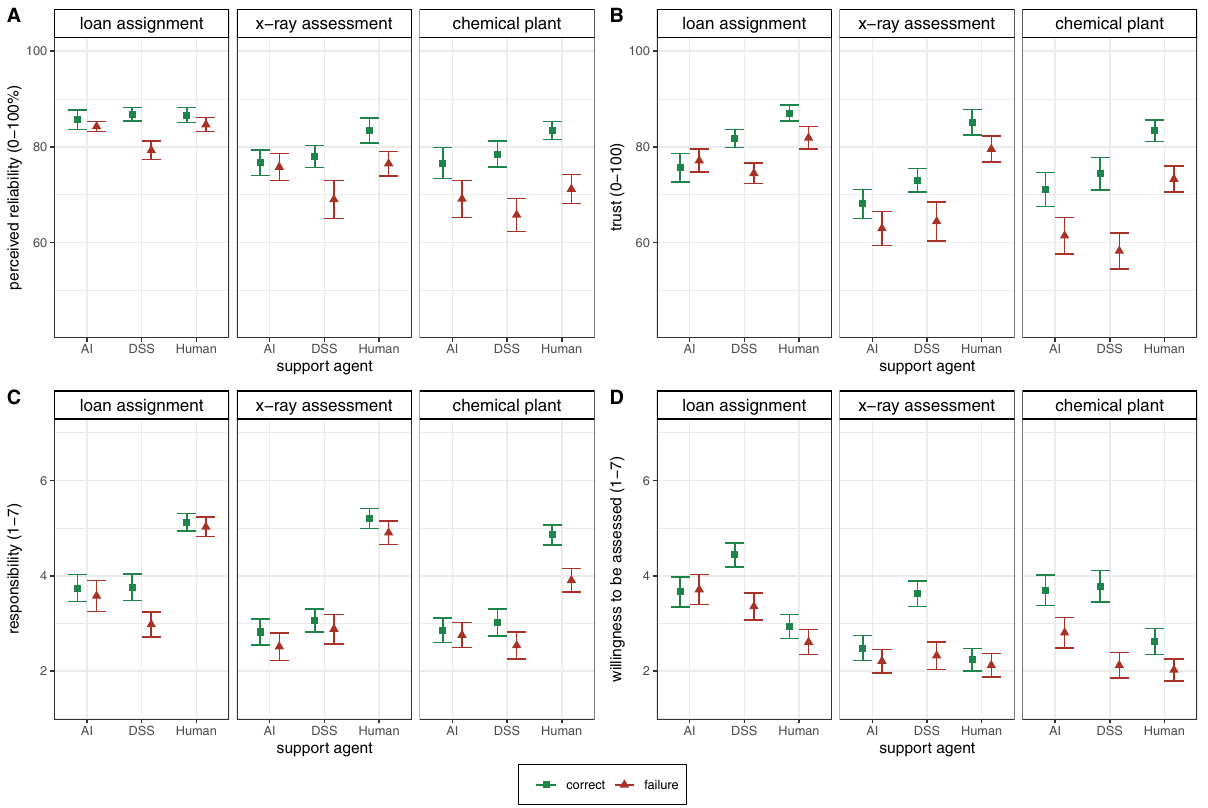
Figure 1. Means and standard errors for ( A ) perceived reliability, ( B ) trust, ( C ) responsibility, and ( D ) the willingness to be assessed by the respective agent as a function of support agent (i.e., AI, DSS, human) and failure condition (i.e., failure vs. all-correct), separately for three experiments with different task contexts (Experiment 1: loan assignment, Experiment 2: X-Ray assessment, Experiment 3: chemical plant). AI = artificial intelligence, DSS = decision support